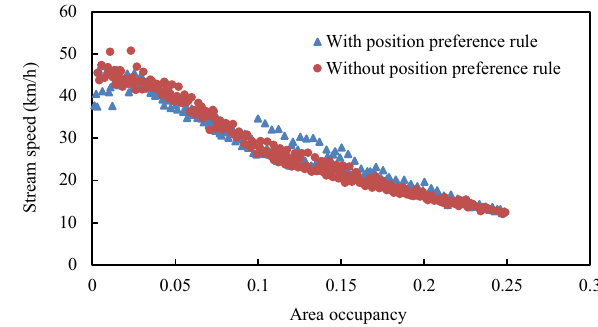
Fig. 8 Flow-occupancy diagram obtained using position preference based on modified CA model